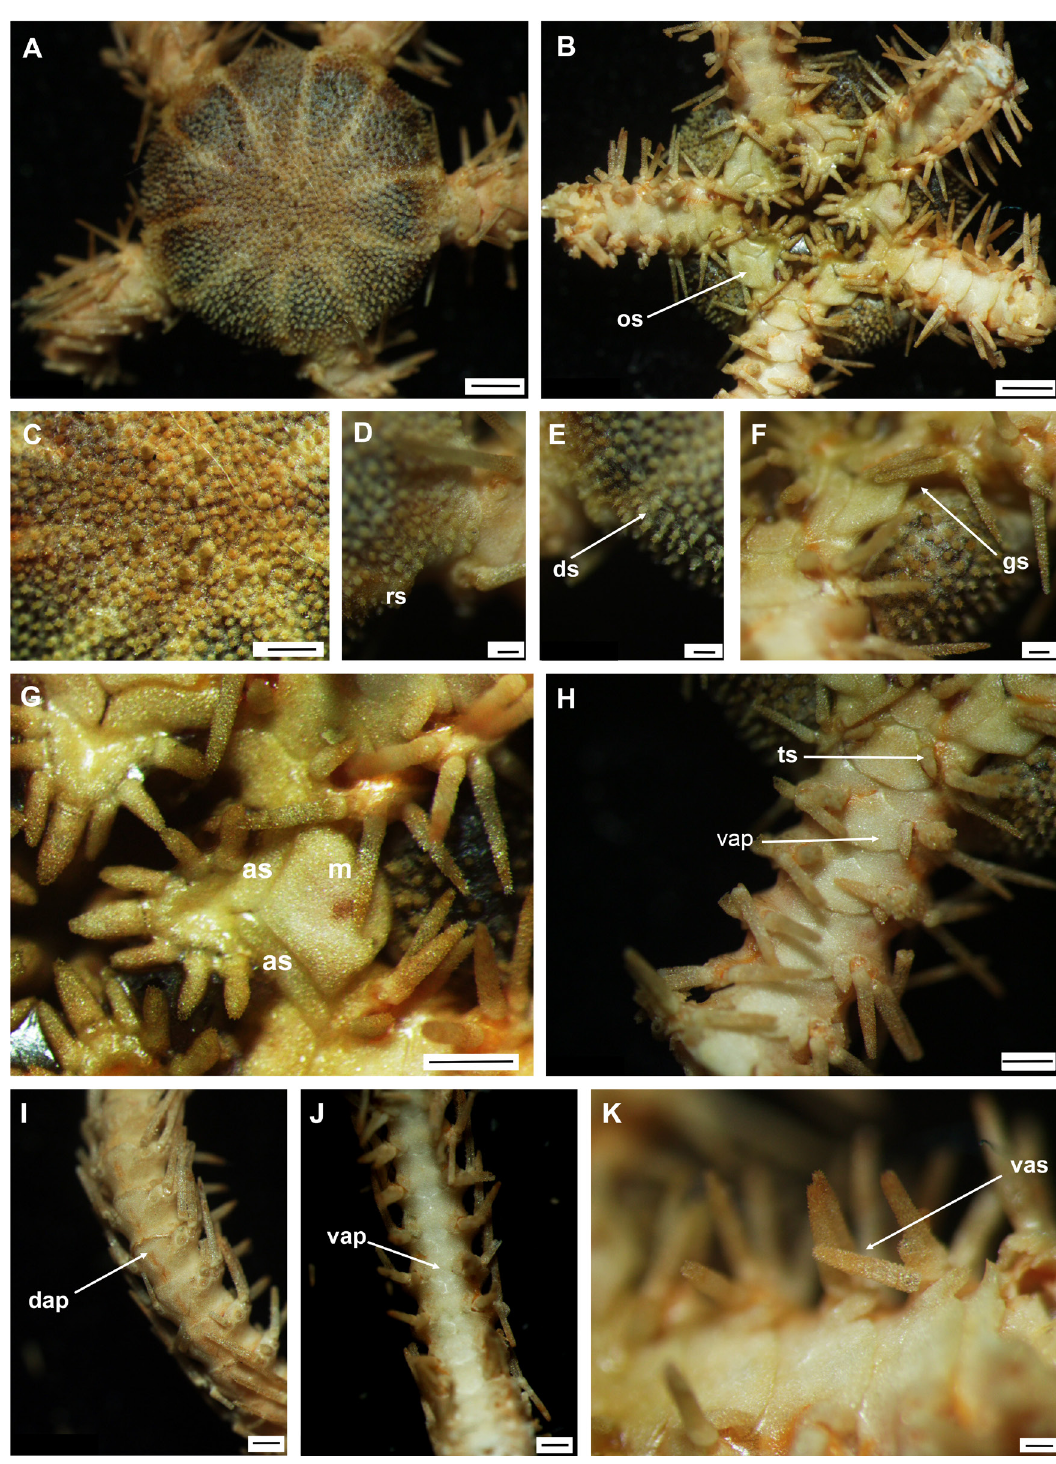
Fig. 29. Ophiacantha vorax Koehler, 1897 (IDSSE EEB-SW0011). A . Dorsal disc. B . Ventral disc. C . Center of disc with tall disc stump. D . Distal area of the radial shield. E . Thorny stumps. F . Lateral disc. G . Oral frame. H . Ventral arm base. I . Dorsal arm. J . Ventral arm. K . Ventralmost arm spine. Abbreviations: as = adoral shield; dap = dorsal arm plate; ds = disc spine; gs = genital slit; m = madreporite; os = oral shield; rs = radial shield; ts = tentacle scale; vap = ventral arm plate; vas = ventral arm spine. Scale bars: A–B = 1 mm; C, F–J = 500 µm; D–E, K = 200